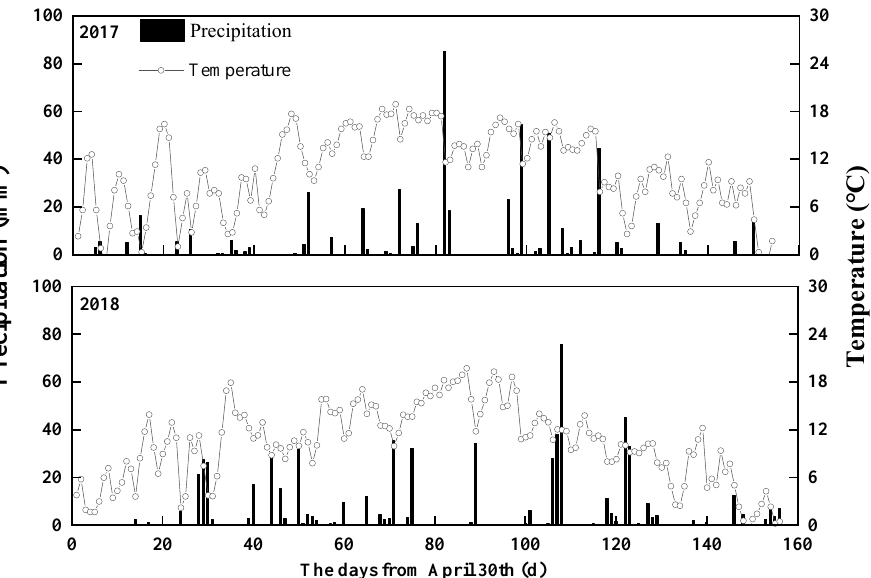
Figure 1. Daily meteorological data for maize growth seasons in 2017 and 2018.